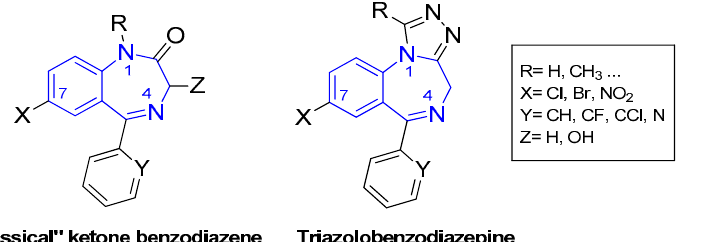
Figure 1. General molecular structures of the most commercialized 1,4-benzodiazepines: ketone and triazole derivatives. The 1,4-benzodizapine core is highlighted in blue.